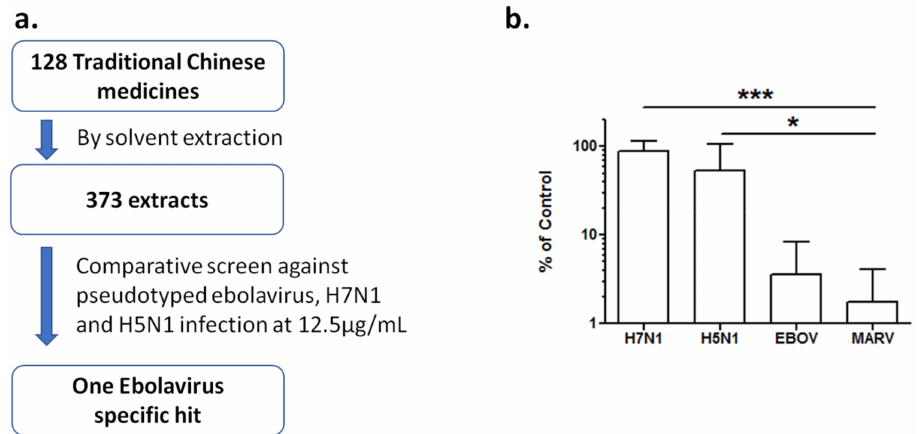
Figure 1. Identification of R. rosea extract as Ebola virus (EBOV) specific inhibitor. ( a ) A